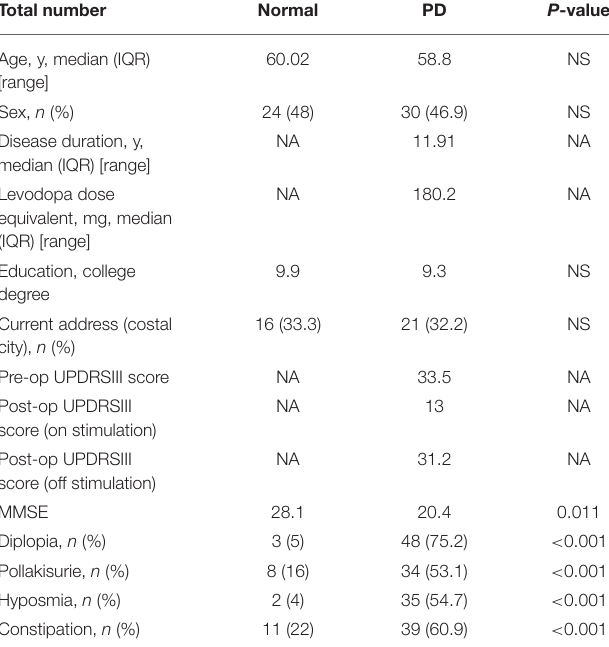
TABLE 1 | Participant